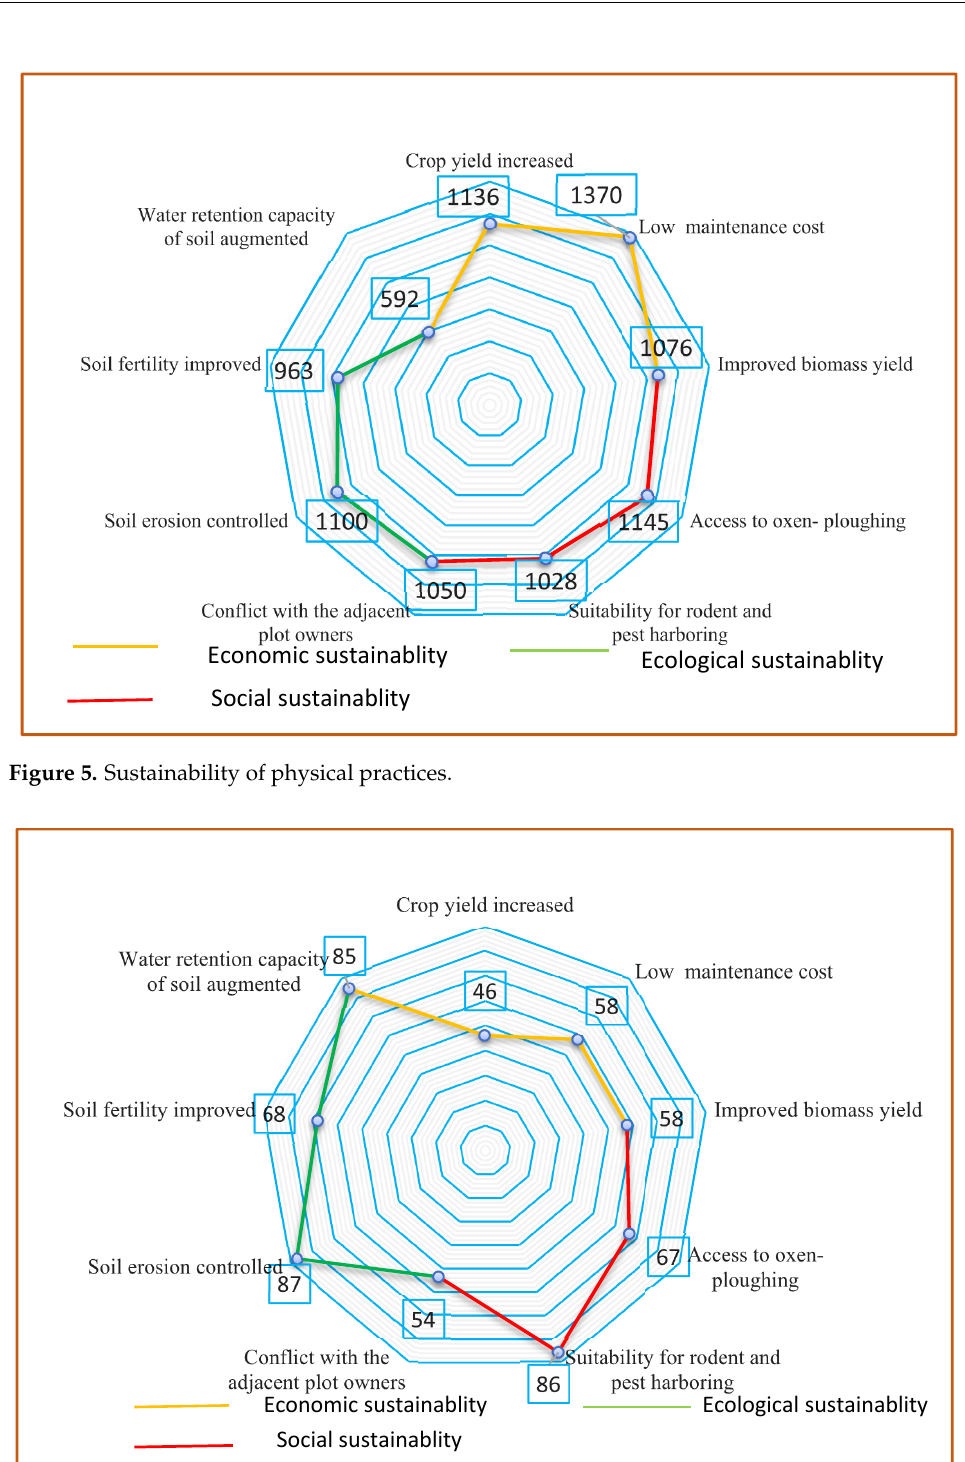
Figure 7. Sustainability of mixed practices. 4.5.4. Correlation between Household Variables and the Sustainability of Physical Prac- tices